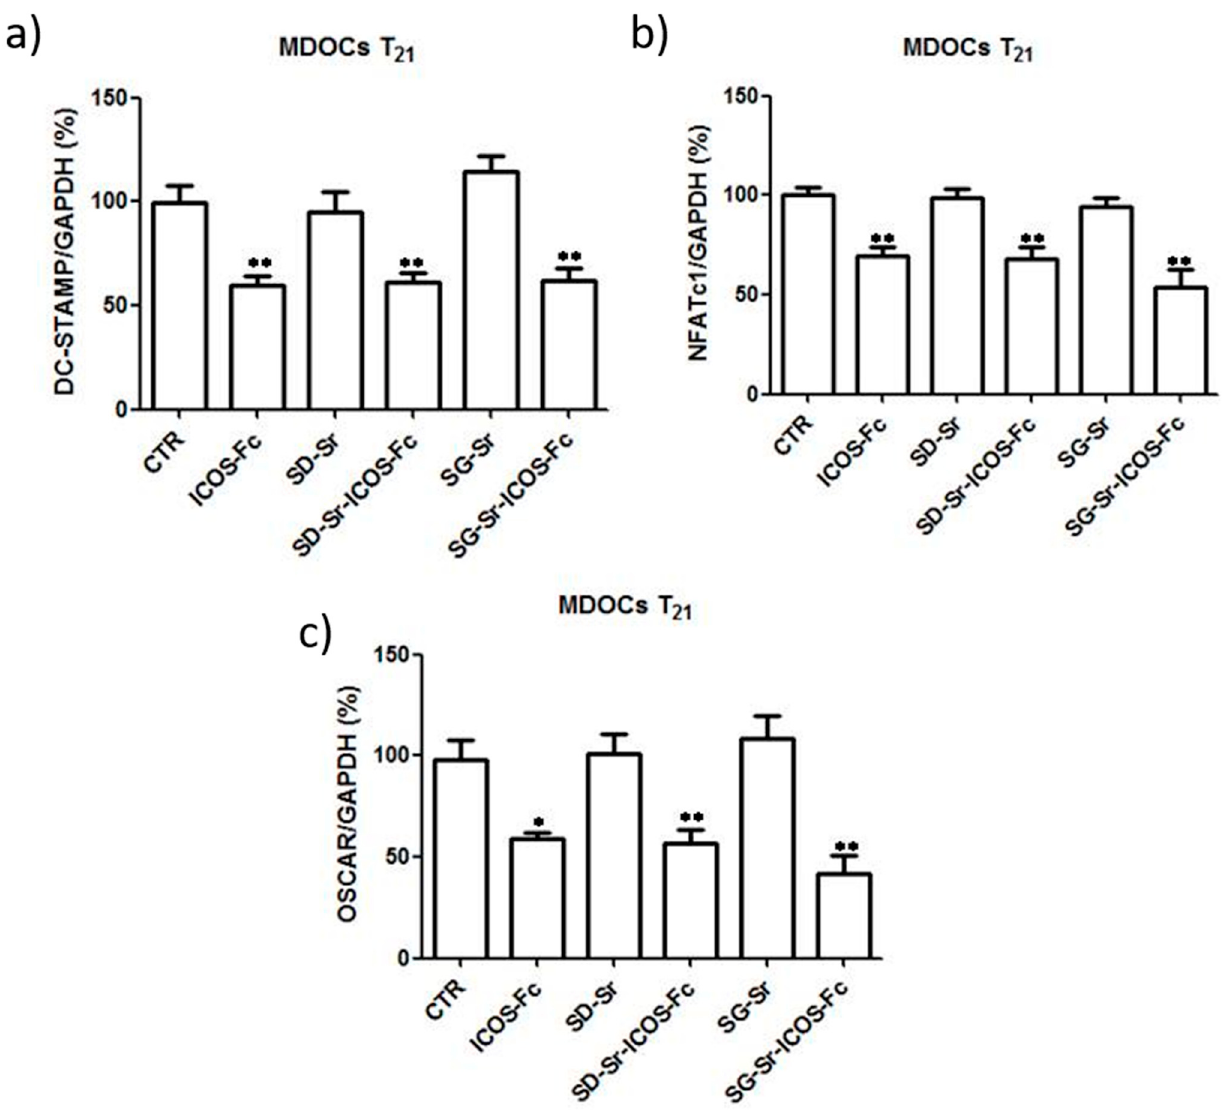
Figure 16. Effect of MBGs reagents on MDOC expression of DC-STAMP, NFATc1, and OSCAR. Bar graphs show the real-time PCR data of expression of ( a ) DC-STAMP, ( b ) NFATc1, and ( c ) DC-STAMP at T21. Data are expressed as the mean ± SEM. The data are normalized for the expression in the control cells (control expression set at 100%). * p < 0.05, ** p < 0.01 versus the control (Dunnett’s test).